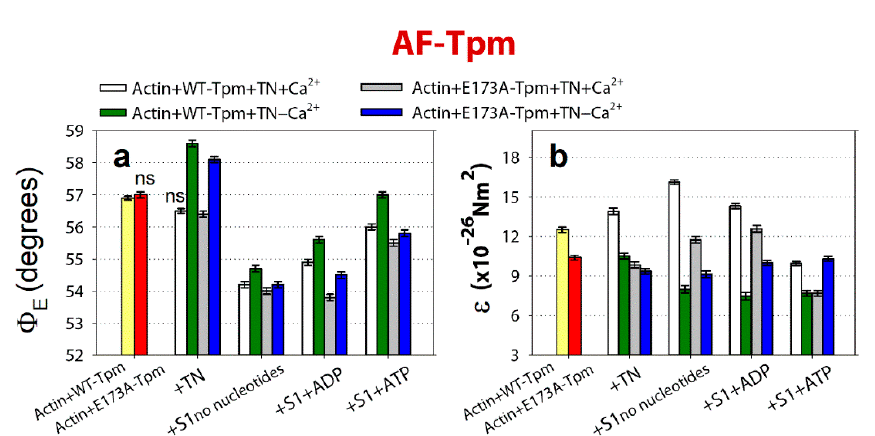
Figure 3. The effect of troponin and Ca 2+ on the values of Ф Е ( a , b ) of the polarized fluorescence for 5-iodoacetamidofluorescein (5-IAF) linked with WT-Tpm and E173A-Tpm was revealed in glycerol-skinned fibres under conditions simulating the sequential steps of the actomyosin ATPase cycle. The relative amount of the WT and mutant Tpms, as well as the amount of S1 in all experiments were monitored by measuring the fluorescence intensity of proteins in the actin-WT-Tpm-S1 and actin-E173A-Tpm-S1 complexes. When simulating rigor and in the presence of Mg-adenosine 5 ′ -diphosphate (MgADP), the molar ratio of S1 to actin was 1:(2.4 ± 0.6) and the molar ratio of tropomyosin to actin was 1:(7.0 ± 0.5). In the presence of Mg-adenosine 5 ′ -triphosphate (MgATP), a reduction in the molar ratio of S1 to actin was seen, which was similar for the WT and mutant Tpms (Section 3). It is supposed that the same fraction of actin monomers bound S1 in each case. The values of Ф Е were corrected in order to take into account the changes in conformation of actin monomers. The first and second entries from the left in each panel present the data obtained in the absence of S1. The data represent the mean values for 5–7 fibres for each experiment (Section 3). The Ф Е and ɛ values in the absence and in the presence of nucleotides are significantly altered by troponin and Ca 2+ for both WT-Tpm and E173A-Tpm ( p < 0.05). Error bars indicate ±SEM. The values of N were close to